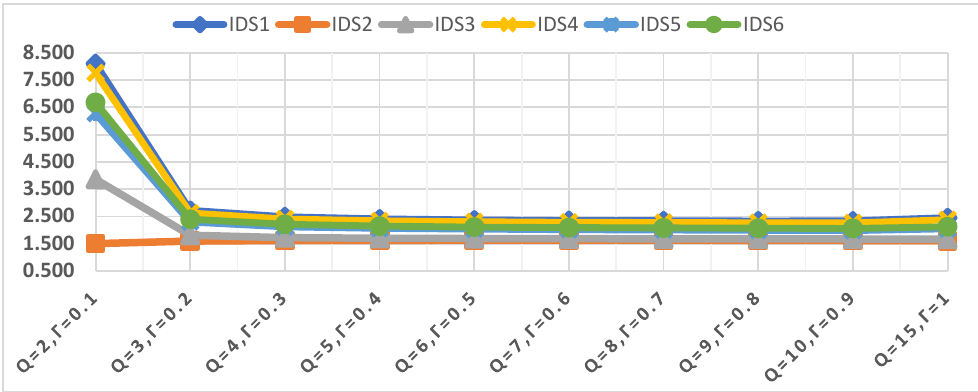
Figure 10. Closeness coefficient values of IDSs in terms of the different values of q and 𝛾 .